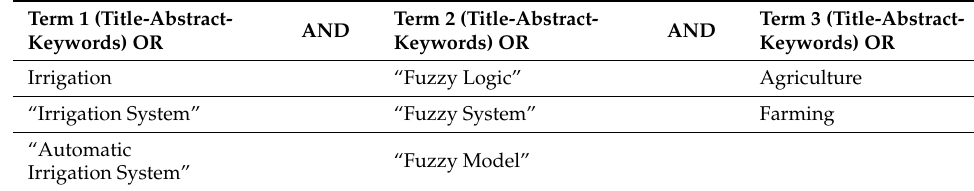
Table 2. The second search equation.